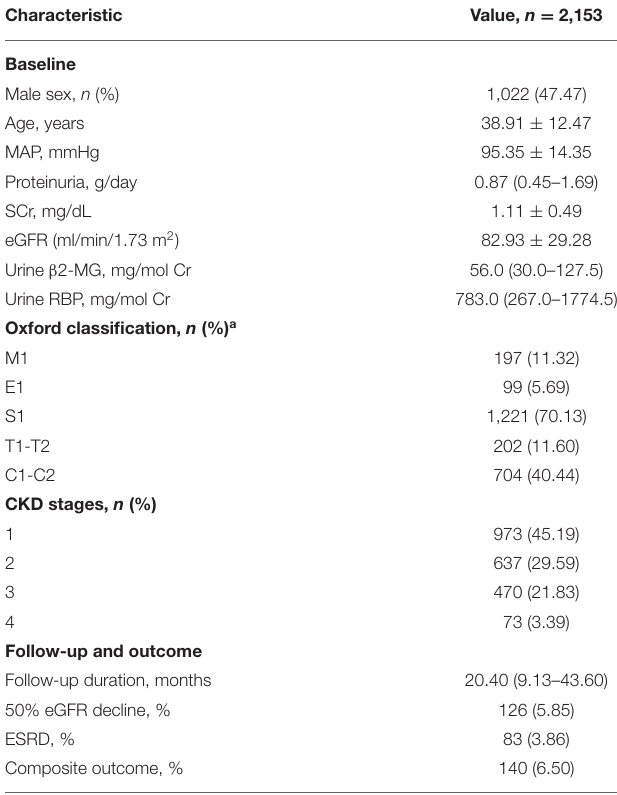
TABLE 1 | Clinical and pathological characteristics of patients with IgA